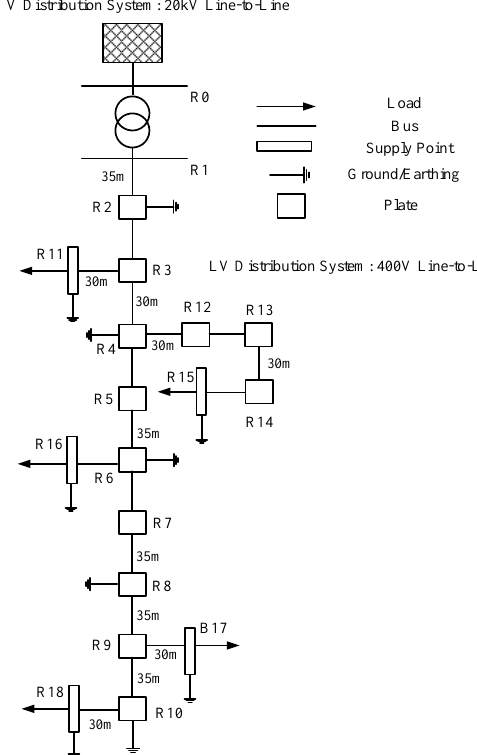
Figure 6. Configuration of urban residential distribution